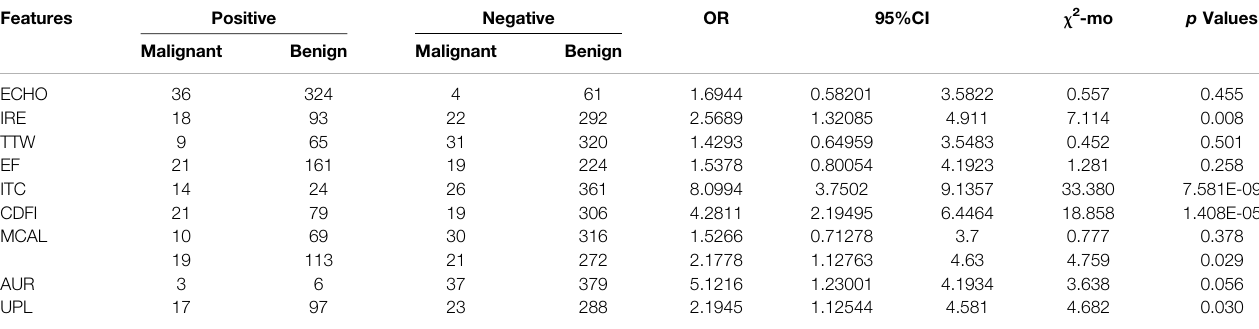
TABLE 3 | Association between ten ultrasound characteristics and MTC thyroid malignancy in the bivariate analysis ( n (cid:1) 425). Features